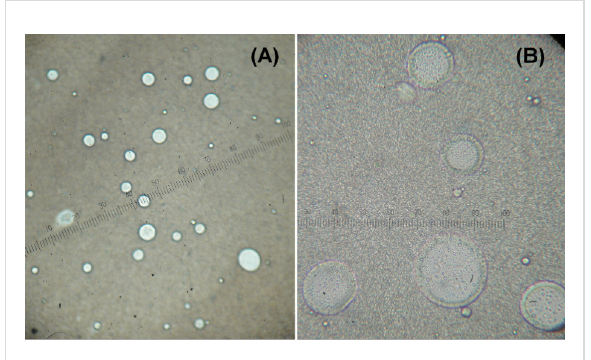
Figure 1: Optical micrograph of the reaction mixture. (A) normal view, (B) magnified view. (Scale bar = 2.5